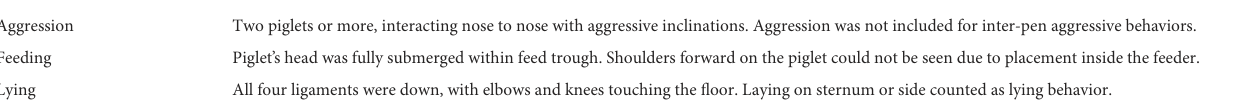
TABLE 1 Definitions of behaviors summarized by validated observers.